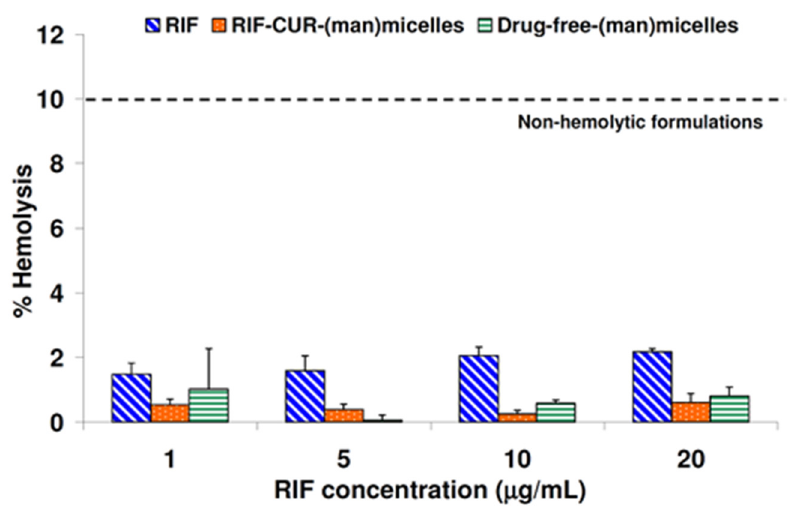
Figure 5. Percentages of hemolysis of RIF, drug-free-(man)micelles and RIF–CUR-(man)micelles at various concentrations after incubation for 3 h at 37 °C. Results are expressed as mean ± S.D. (n = 3).